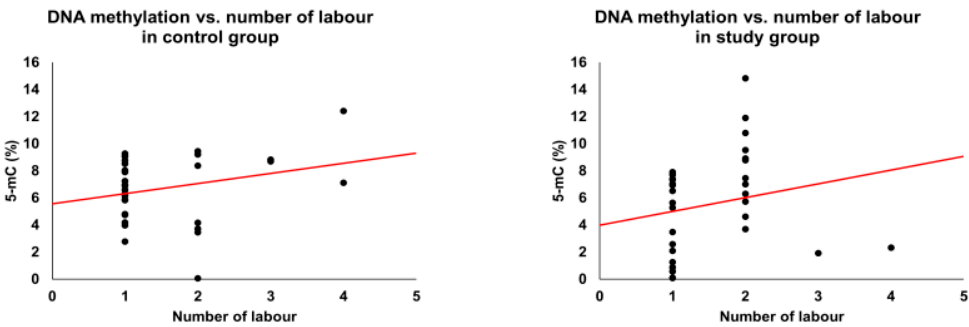
Figure 3. Global methylation level and number of labors. The red line represents linear correlation.